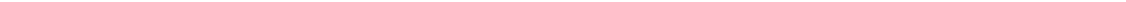
Fig. 1 Dicer-CKO MG Müller glia migrate and form aggregations. a Schematic of the wild-type (wt): Rlbp1CreER: stop f/f -tdTomato and the conditional knockout (Dicer-CKO MG ) genotype: Dicer1 f/f : Rlbp1CreER: stop f/f -tdTomato . b Experimental design. c – v Immuno fl uorescence for tdTomato, glutamine synthetase (GS), Sox9 or Sox2, and DAPI nuclear staining of wt and Dicer-CKO MG retinal sections, 1 month ( c – j ) or 6 months after Dicer1 deletion ( k – v ). MG form aggregates in central retina ( q ) and display abnormal migration in the periphery ( t ). w Distribution (%) of tdTomato + MG in the different retinal layers in wt and Dicer-CKO MG retinas, wt: n = 10, CKO 1 mo : n = 8, CKO 6 mo : n = 4. x Numbers of tdTomato + MG per fi eld in wt and Dicer-CKO MG retinas, wt 1 mo : n = 5, CKO 1 mo : n = 9, wt 6 mo : n = 4, CKO 6 mo : n = 4. y Numbers of Sox2 + or GS + tdTomato + glia in the center and periphery of 6 months old